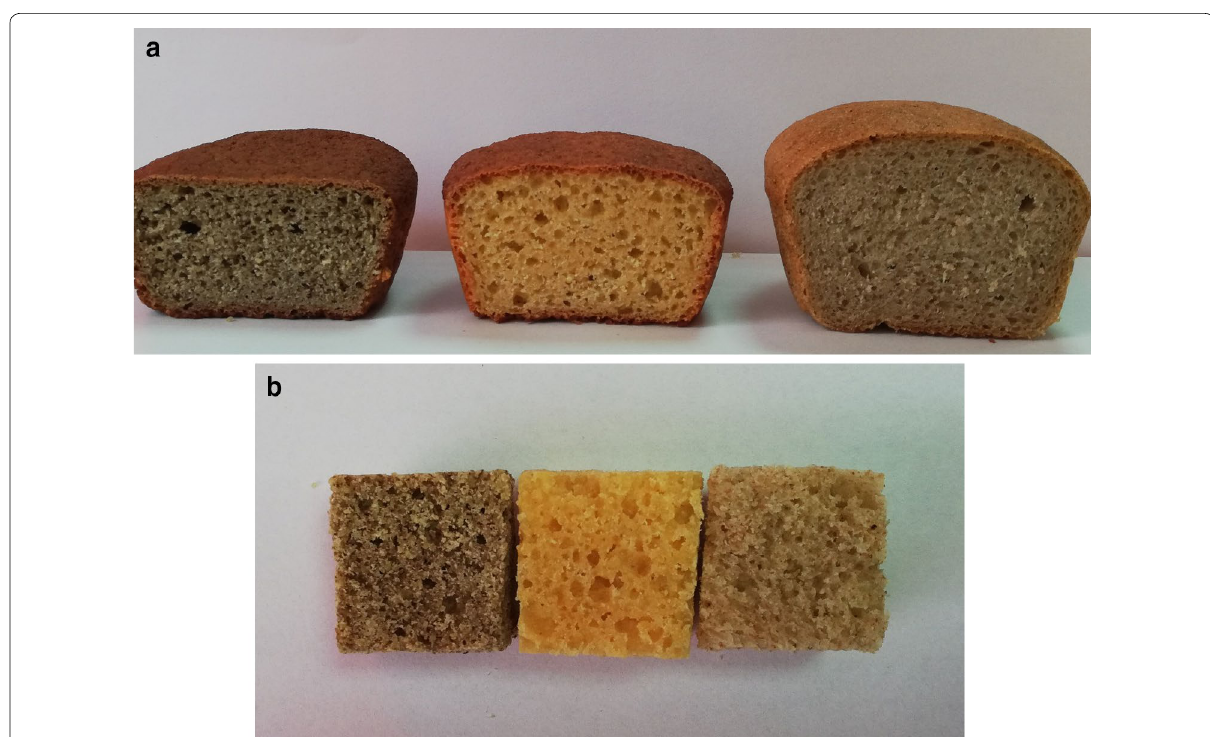
Fig. 1 Sections ( a ) and middle crumb ( b ) of the obtained wheat-lentils bread samples as compared to a control wheat bread (from left to right: wheat–green lentil, wheat–red lentil and wheat control bread samples)